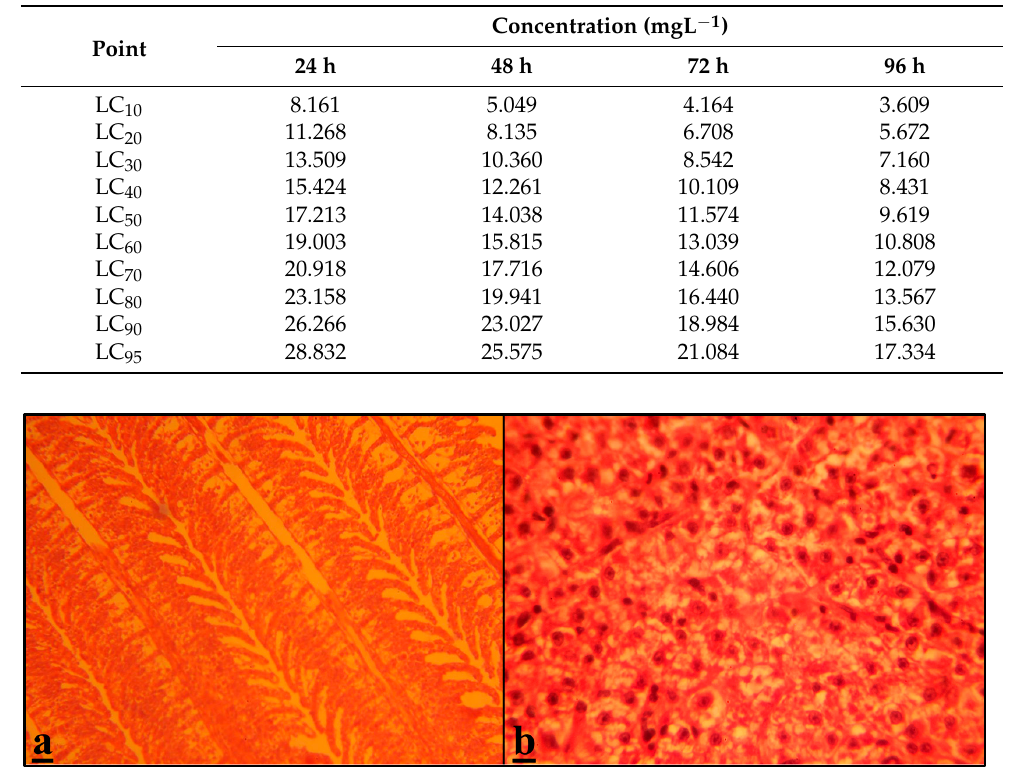
Table 2. Lethal concentrations of Ag-NPs to C. capoeta.